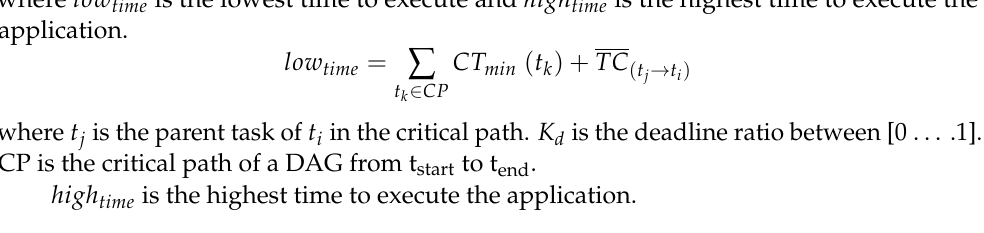
Algorithm 1 POTC Planning Algorithm. Require: W = G (T,E)